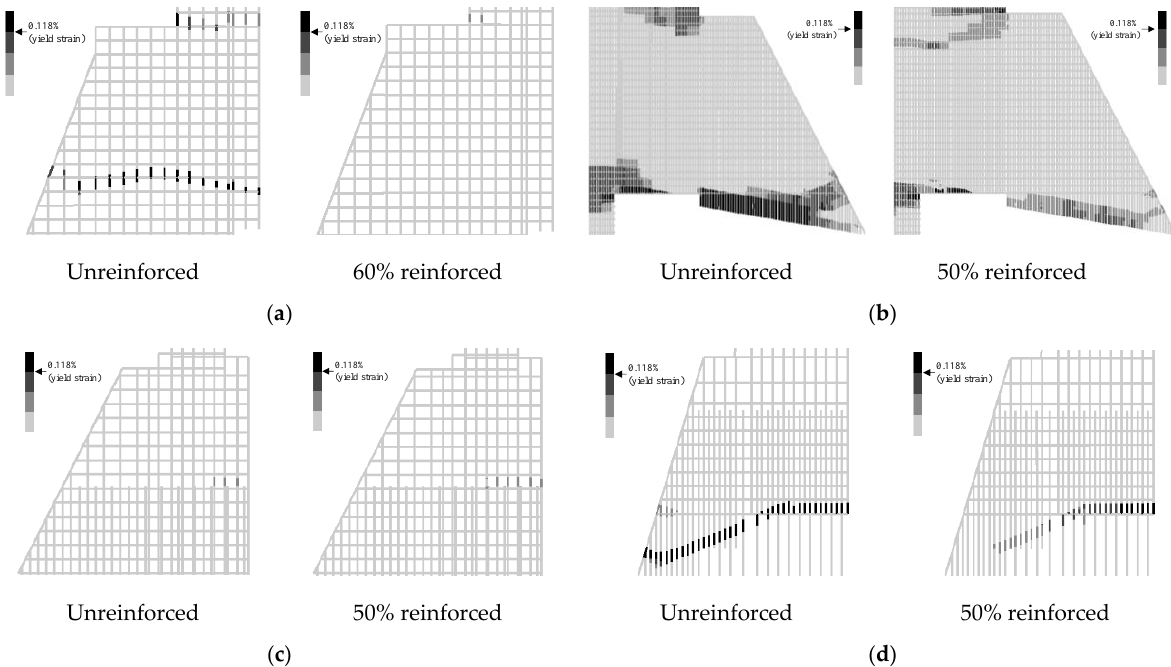
Figure 33. Strain distribution of existing reinforcing bars at peak displacement in wave A: ( a ) Type-A; ( b ) Type-B; ( c ) Type-C; ( d ) Type-D.